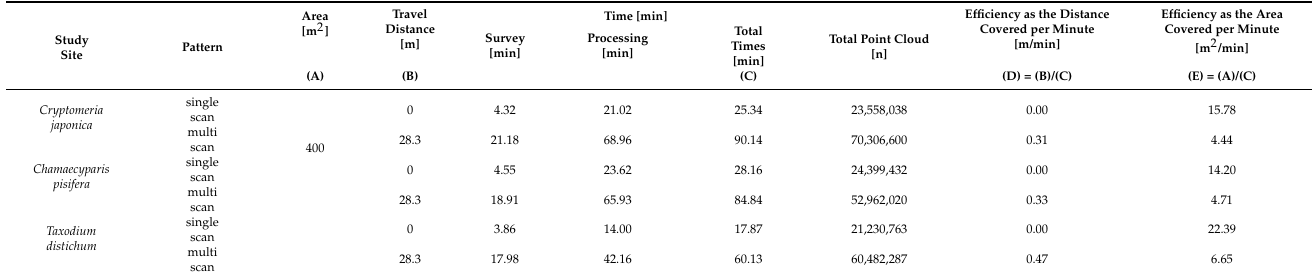
Table 12. Comparison of the amount of time required to gather and process the data with the TLS according to scan